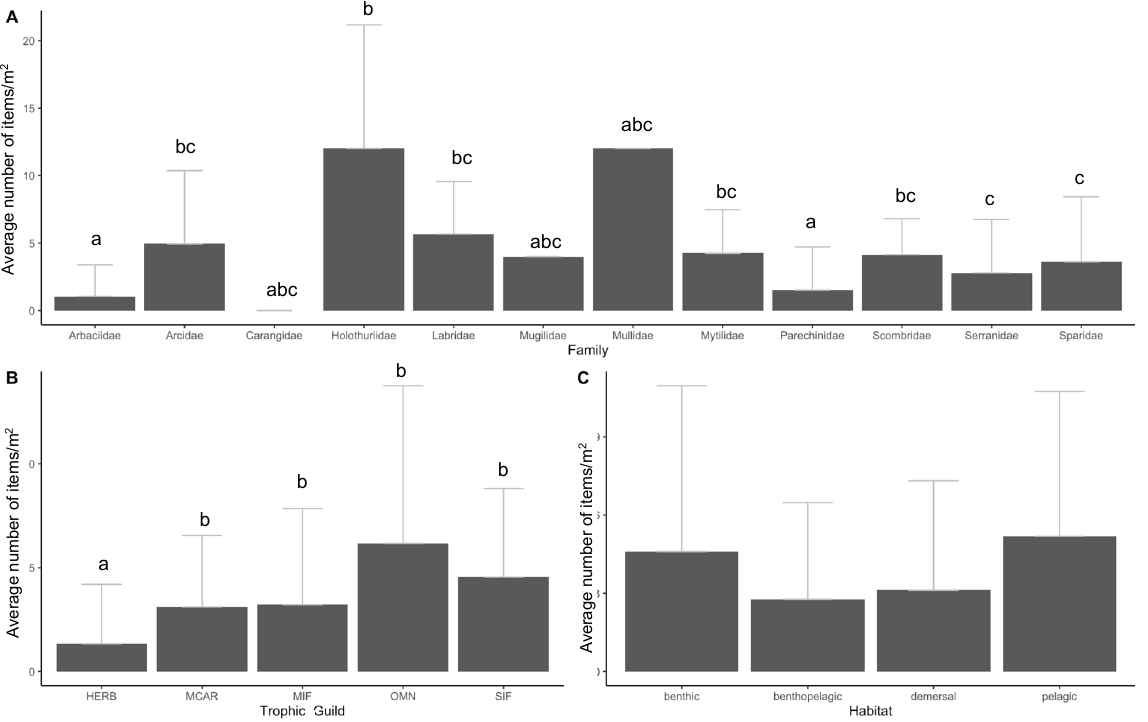
Figure 9. The mean number of anthropogenic particles (mean ± standard deviation) found in the study species regarding family ( A ), trophic guild ( B ) and habitat ( C ). Error bars indicate a 95% confidence interval and significant differences are indicated by different letters. The significance level was established at p < 0.05.